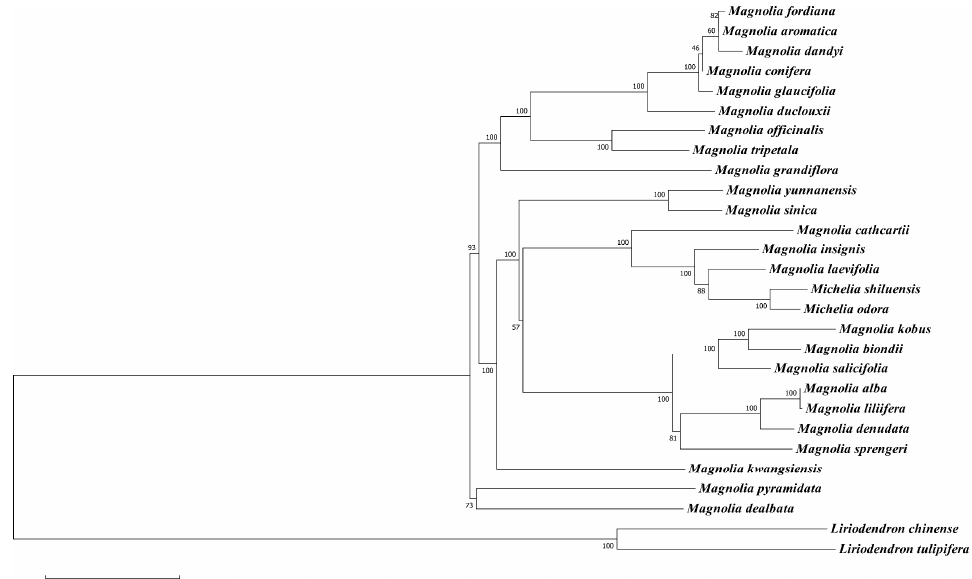
Figure 8. Maximum likelihood tree with 1000 bootstrap replicates constructed using RAxML based on chloroplast genomes of 28 Magnoliaceae species (26 species of Magnolia and Michelia , and two species of Liriodendron as outgroups). Bootstrap values (%) are shown above branches. Accession numbers: